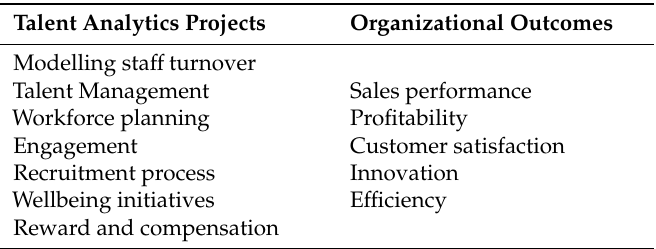
Table 1. Mapping talent analytics projects to organizational outcomes.